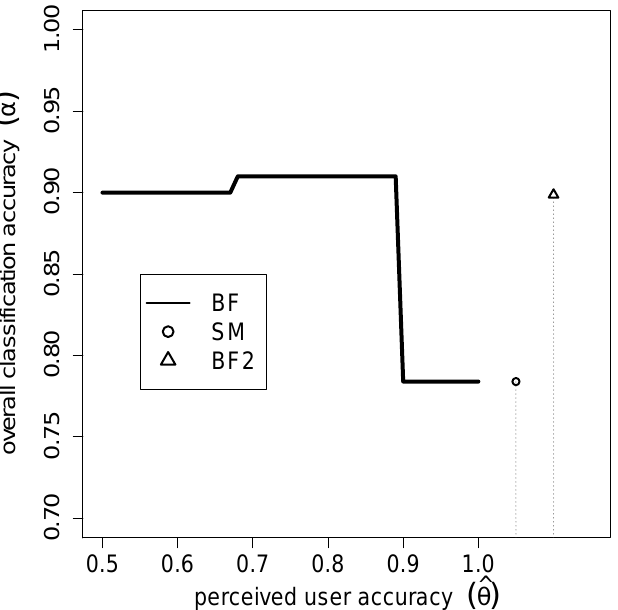
Figure 3. The overall classification accuracy α for BF as a function of the perceived user accuracy ˆ θ when p 1 = 0.9, θ = 0.7 and n = 12. The classification user accuracy for SM and for BF2 when m = 11 and n = 11 are given for comparison. For the same cost Um + In , BF2 generally performs better than the other